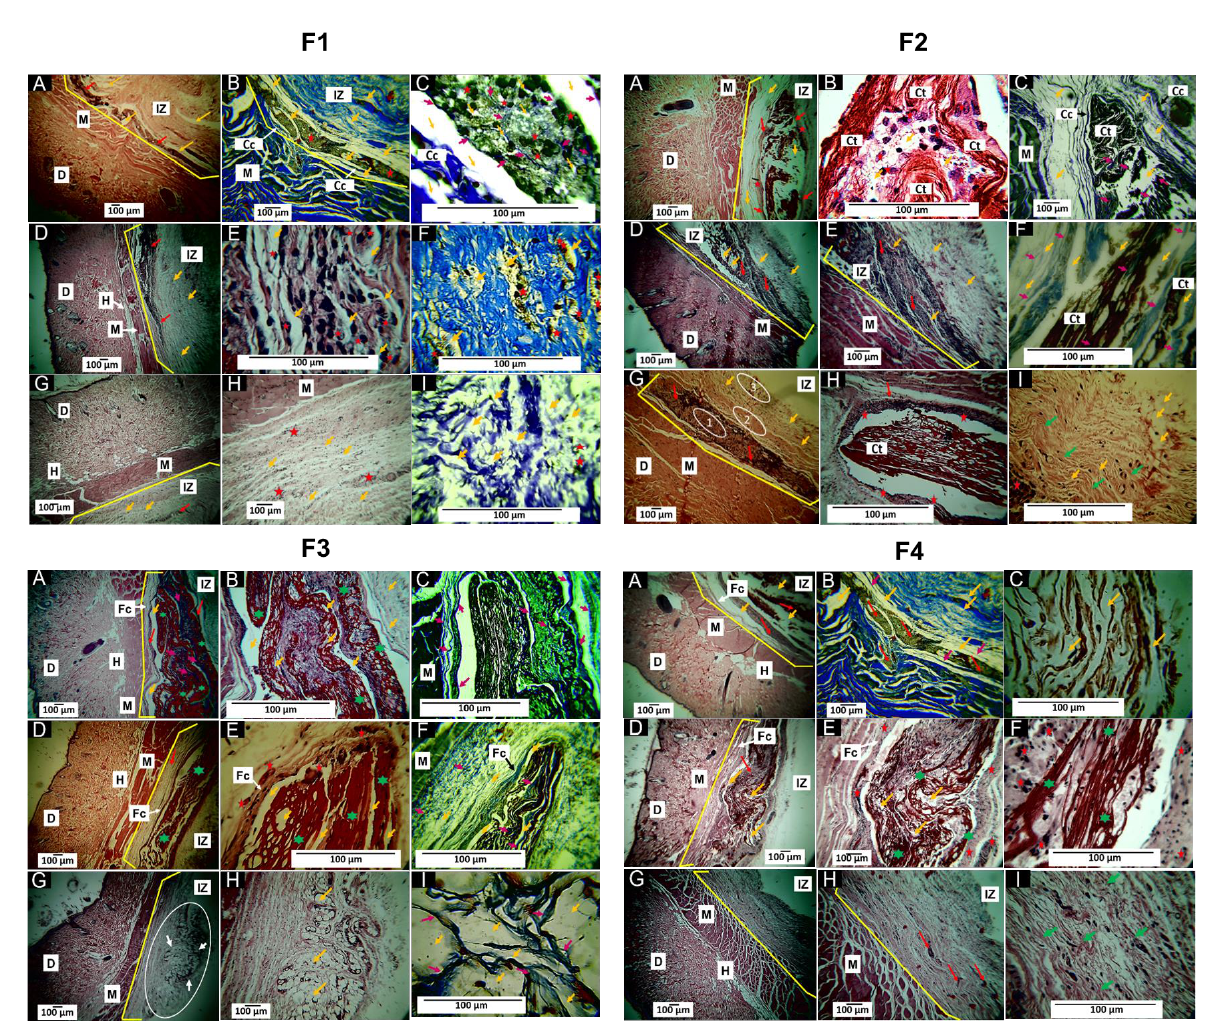
Figure 8. Histological analysis of F1, F2, F3, and F4 membranes. ( A – C ): 30-day implantations. ( D – F ): 60-day implantations. ( G – I ): Implantations at 90 days. ( A ): Image at 4× HE technique. ( B ): Image at 100× HE technique. ( C ): Image at 10× MT technique. ( D ): Image at 4× HE technique. ( E ): Image at 10× HE technique. ( F ): Image at 40× MT technique. ( G ): Image at 4× HE technique. ( H ): Image at 40× MT technique. ( I ): Image at 40× HE technique. D: Dermis. M: Muscle. IZ: Implantation zone. Cc: Connective tissue capsule. Ct: Connective tissue. Red arrow: area with resorbing material. Yellow arrow: F1 material. Pink arrows: type I collagen fibers. Red arrows: inflammatory cells. Green arrows: Connective tissue. Oval 1: Area with the material in the process of resorption. Oval 2: Zone with less inflammatory activity. Zone 3: Zone with the formation of connective scar tissue. MT: Masson ’ s trichrome stain. HE: Hematoxylin-Eosin stain.